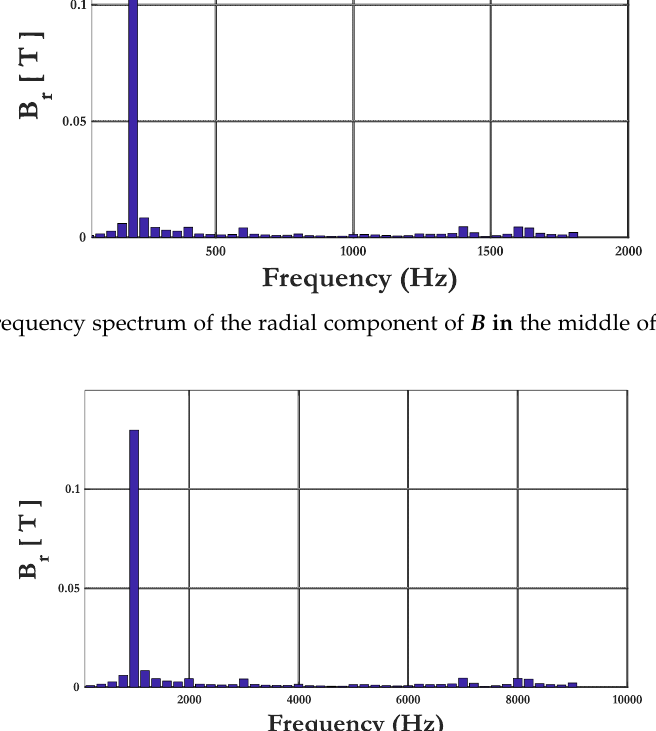
Figure 20. The frequency spectrum of the radial component of B in the middle of the North PM at 3000 rpm.